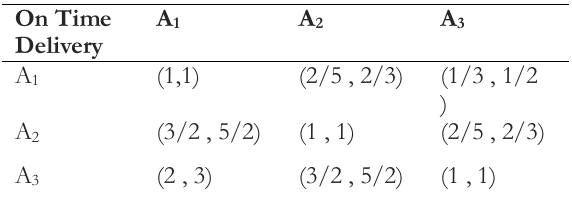
Table 8. Suppliers compared with on time